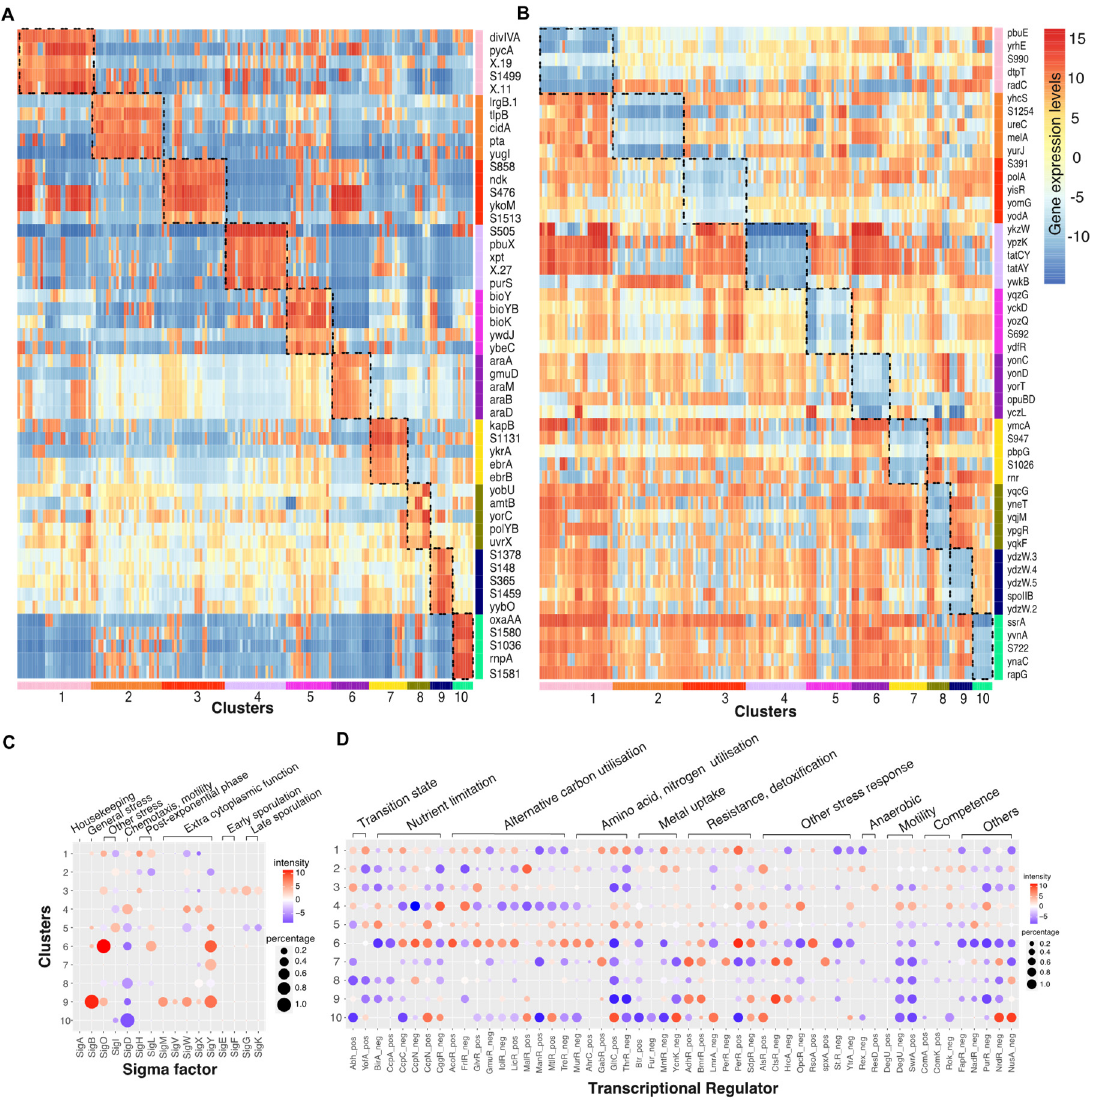
Figure 3. Cellular state inference for clusters. ( A ) Top5 (by p -Values) upregulated genes that are specific for each cluster. ( B )) Top5 (by p -Values) downregulated genes that are specific for each cluster. ( C ) Inferred activities of selected sigma factors in each cluster. ( D ) Inferred activities of selected transcriptional regulators (TR) in each cluster. Dot colours represent the average intensity with red indicating activation while blue indicating repression. Dot sizes represent the percentage of samples within the cluster that sees the significant upregulated or downregulated expressions in genes targeted by that sigma factor or regulator. The sigma factor or regulator is activated (repressed) in a sample if the average expression of the genes regulated is higher (lower) than the 70th (30th) percentile expression in the whole transcriptome. The inferred activities for the full list of sigma factors and TRs are given in Supplementary Table